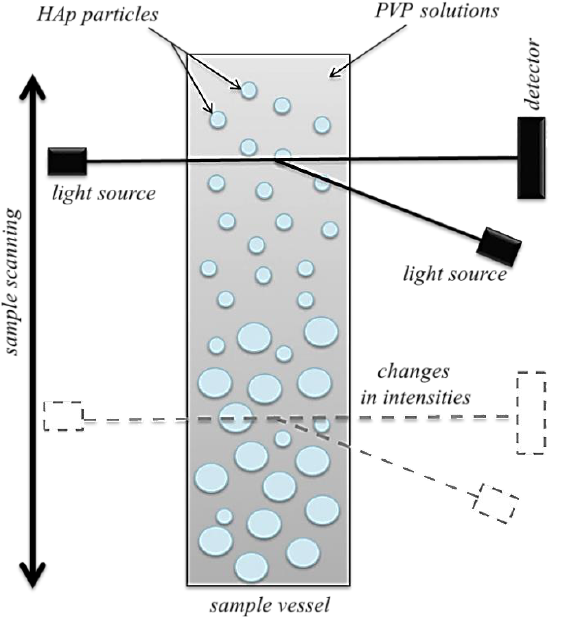
Figure 12. The scheme of the investigations on the stability of HAp suspension in PVP solution. Measurements were performed at 25°C. In the case of all samples, the study was conducted for 10 min (1 scan/20